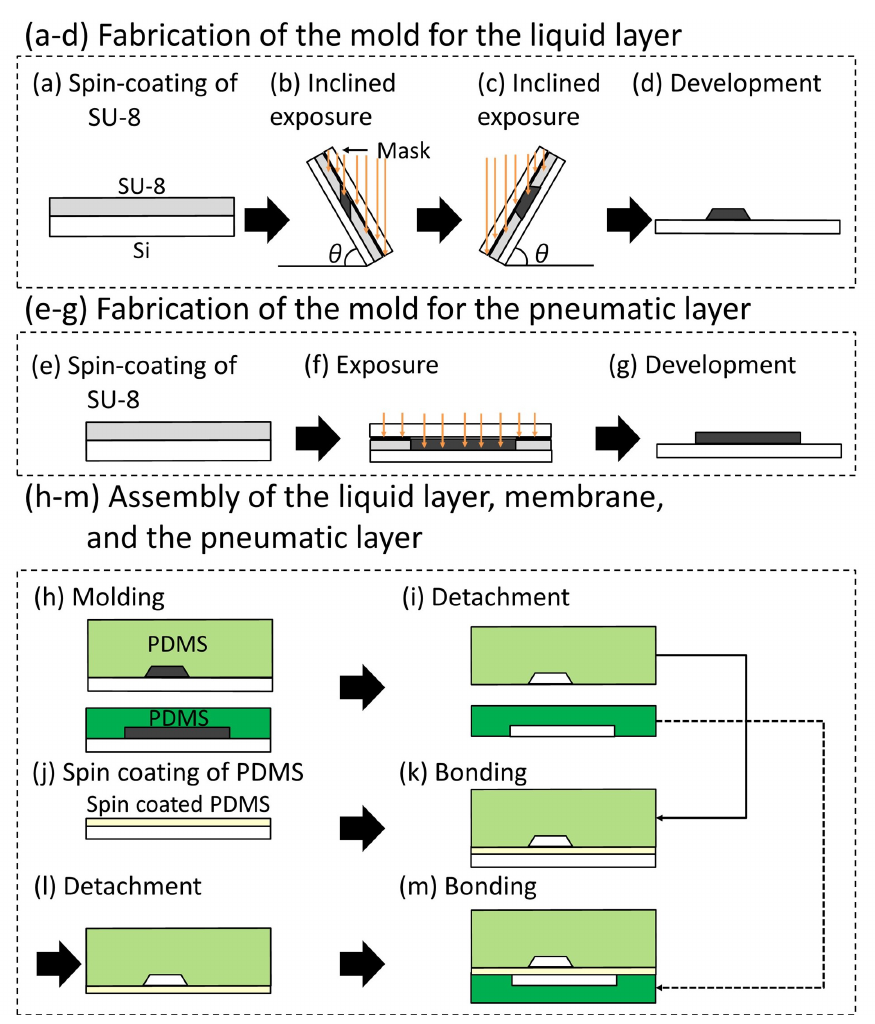
Figure 6. Fabrication process of the pneumatic microvalve with trapezoid-shaped cross-section liquid